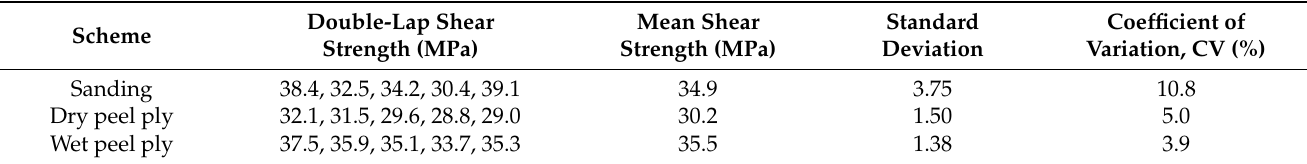
Table 2. Bonding performance of composite